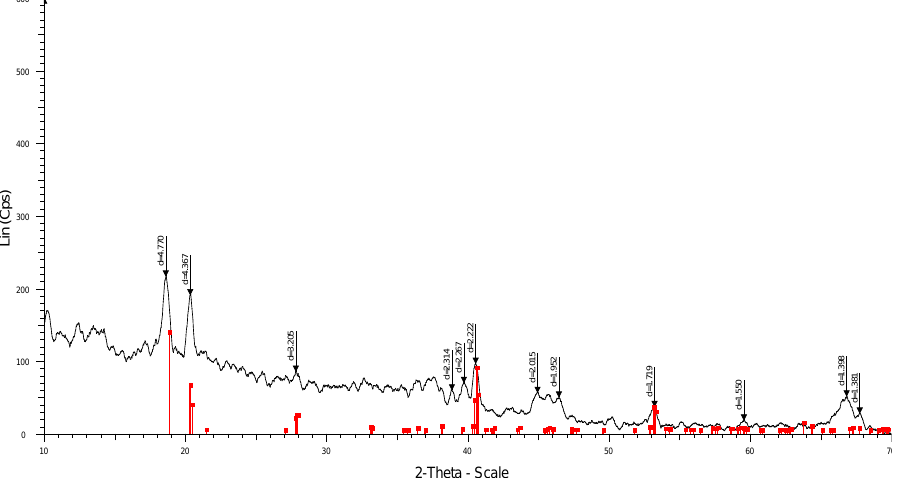
Figure 13. XRD pattern of nano aluminum hydroxide (NAH) after lindane adsorption and SDS modification.